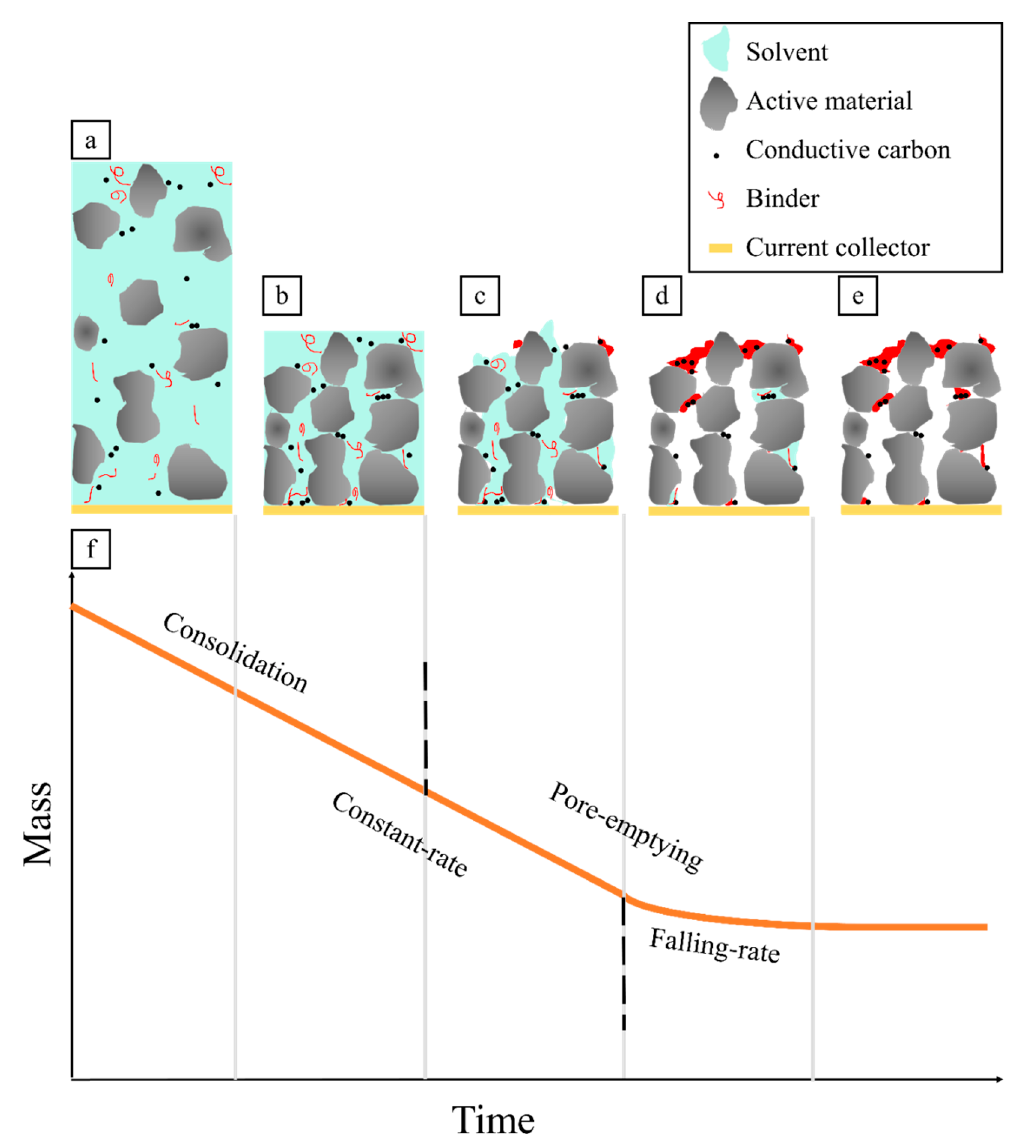
Figure 1. Illustration of the electrode-film drying mechanism: by means of consolidation ( a , b ) and pore emptying ( c , d ), to achieve a fully dried electrode ( e ). The drying curve ( f ) can also be divided into constant-rate and falling-rate regimes.